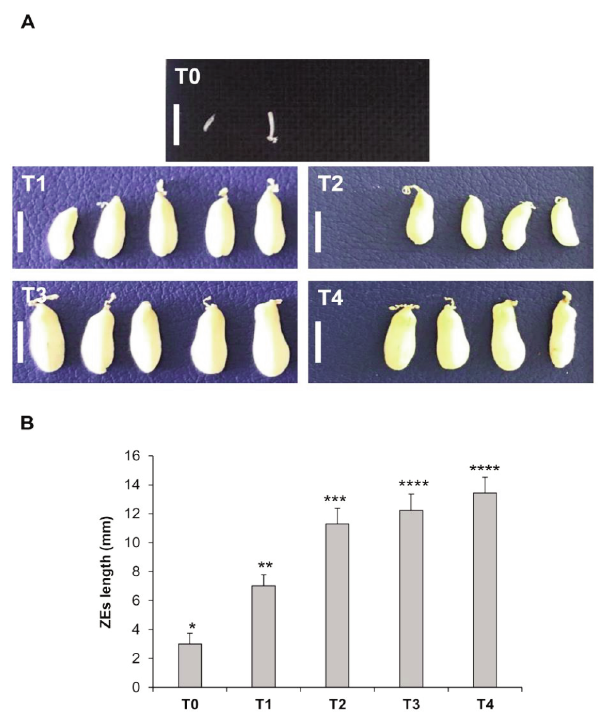
Fig. 1 ­ Effect of warm stratification treatments on Cycas revolu‐ ta embryos length. (A) Zygotic embryos isolated from seeds subjected to T0, T1, T2, T3 and T4. Scale bars=1 cm. (B) Zygotic embryos length in the different treat­ ments. Bars are mean ± SD of at least thirty biological replicates. Asterisks indicate statistical difference accor­ ding to Tukey test (p<0.05).